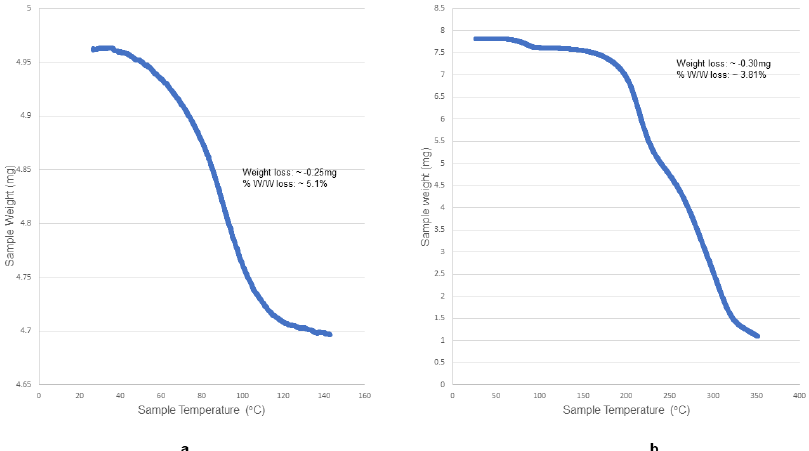
Figure 8. TGA curves showing the weight loss and % w / w loss for the hydrate nicontinate and benzoate salts. ( a ) TGA for BQ nicotinate, lost ~0.25 mg of its weight when the sample was heated up to 140 ◦ C. ( b ) TGA for BQ benzoate, lost ~0.30 mg of its weight when the sample was heated up to 140 ◦ C.